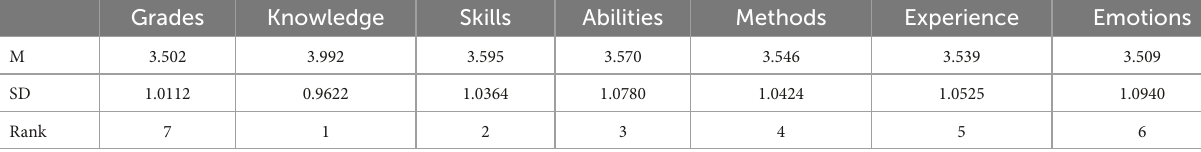
TABLE 4 The M, SD, and rank of the influences of textbook use on mathematics